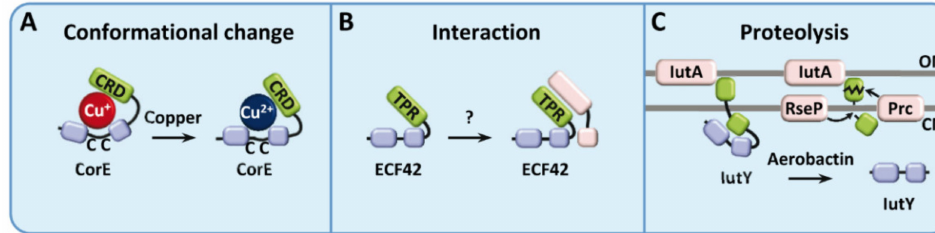
Figure 3. Anti-sigma factors governed by regulatory extensions. ECF sigma factors are depicted in blue, whereas their regulatory extensions and other regulatory proteins are depicted in green and pink, respectively. ( A ) The CorE C-terminal extension (CRD) from M. xanthus responds to copper redox state; ( B ) Regulation by protein interaction of ECF42; ( C ) IutY from P. putida is degraded by the carboxypeptidase Prc and the metalloprotease RseP. OM: outer membrane; CM: cytoplas- mic